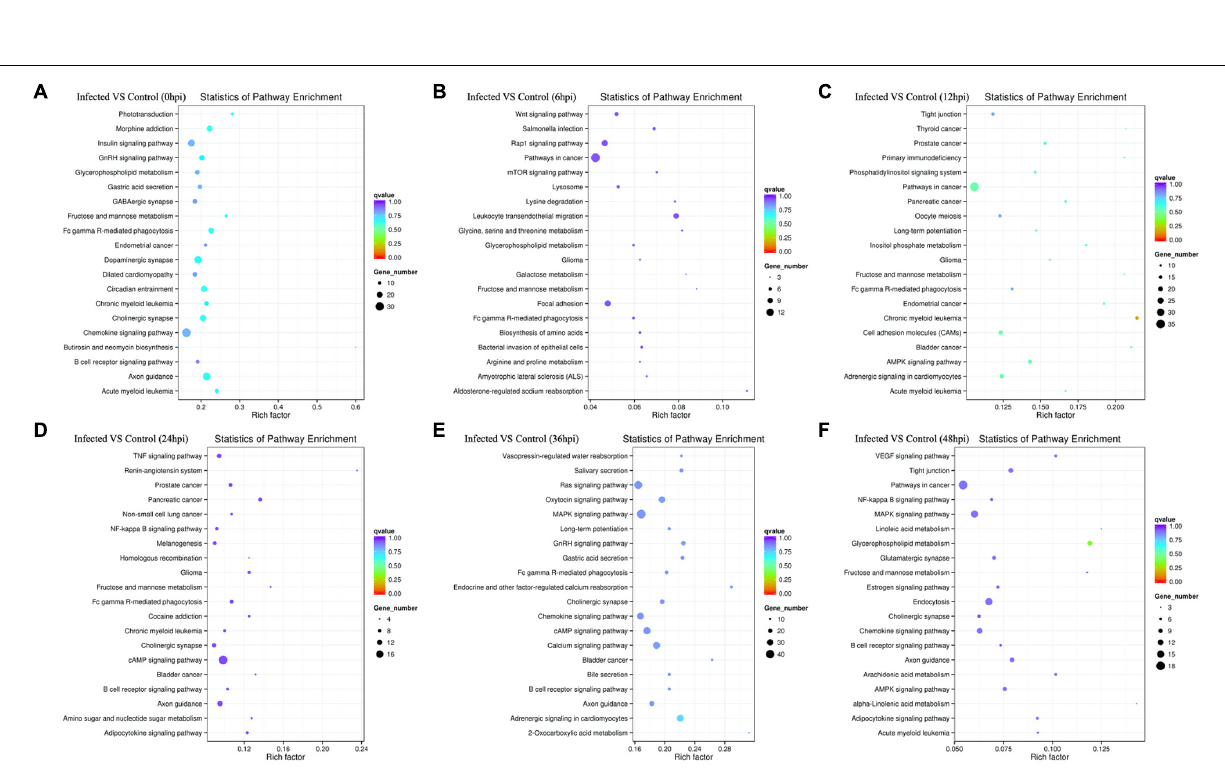
Frontiers in Microbiology |